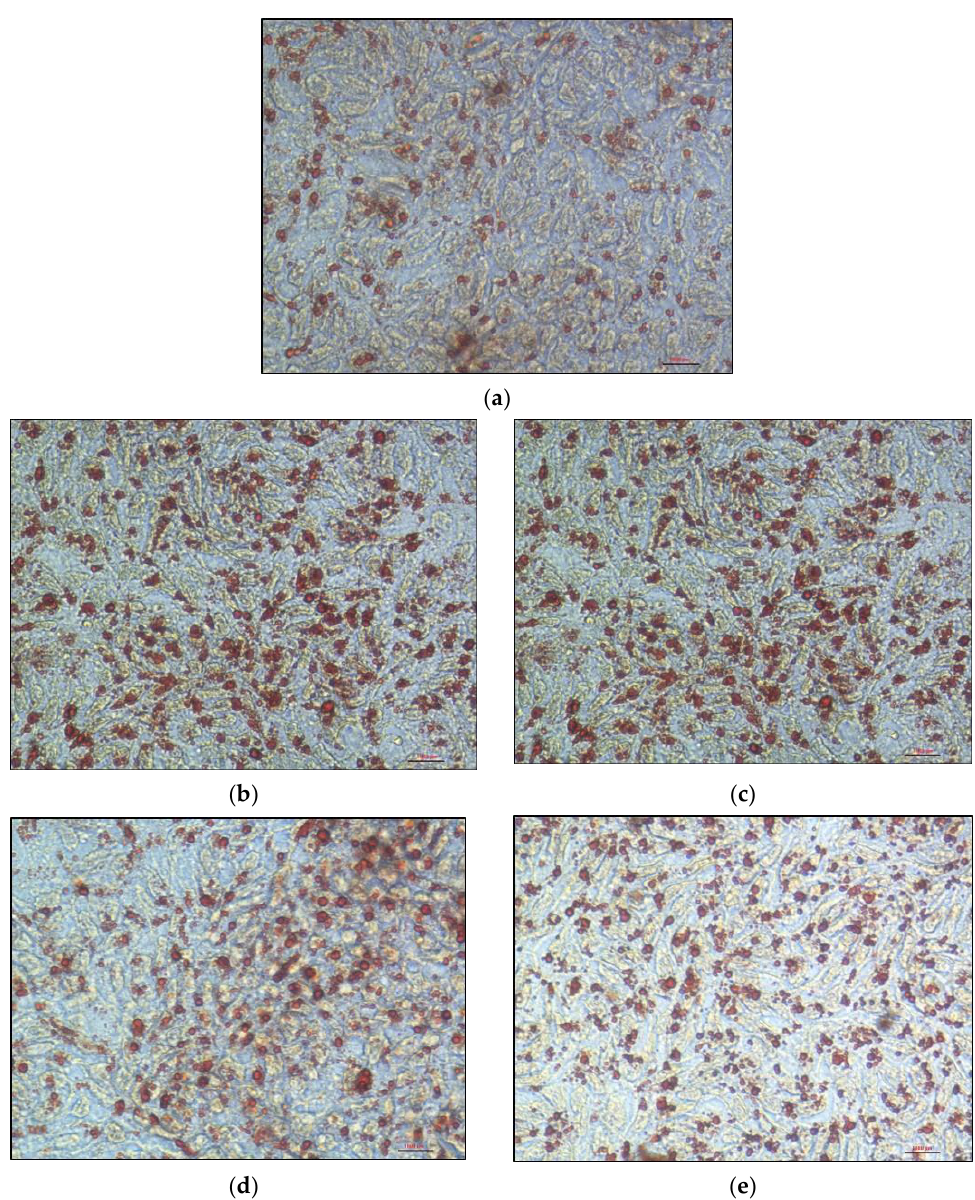
Figure 6. Representative images of cytoplasmic lipid droplets were observed under inverted microscopy images. Cells were cultured in 24-well plates for 21 days and received a medium containing 16% FBS (instead of 8% FBS) for 24 h. Oil Red O staining (×400 magnification) was performed in ( a ) wild-type Caco-2/TC7 cells, ( b ) clone MTTP -KO1, ( c ) clone MTTP -KO2, ( d ) clone SAR1B -KO1 and ( e ) clone SAR1B -KO2.